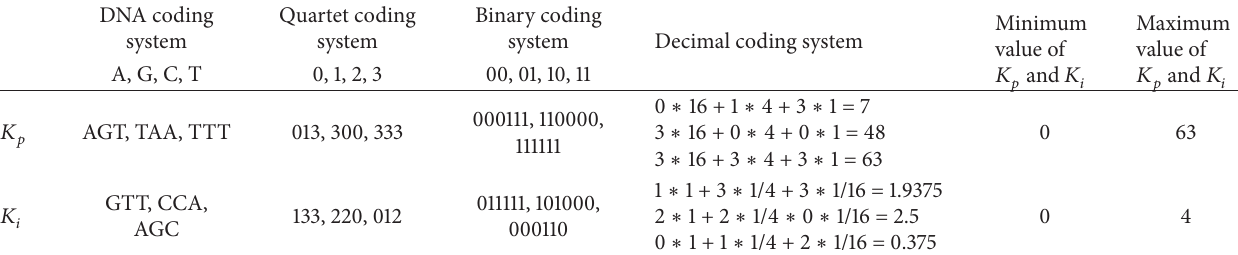
Table 1: Coding table of DNA computing